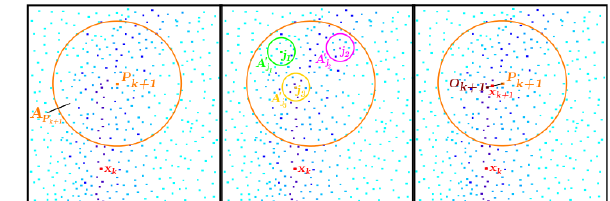
Figure 4: Description of the observation selection step. The blue points are the LIDAR points, and the darker blue they are, the closer of θ they are. The A 0 regions are the regions within curb p which points are used to compute W p (see Eq. 3) and are shown , j 3 for three points j 1 , j 2 and j 3 . Among all the points in A P k +1 is the chosen observation. ( S value was set to 1.5) of W . As soon as W is higher Obs Obs Figure 3: The road side detection steps from time k to time k +1 . than 1 , α ( W ) is equal to 1 and the model only follows Obs (a) LIDAR points and previous results x , . . . , x . (b) poly- S k − 4 k nomial fitting by a curve C (c) selection of the prediction P . k +1 the search area around P . (e) selection of the best (d) A P k +1 k +1 observation O (f) new result x . k +1 k +1